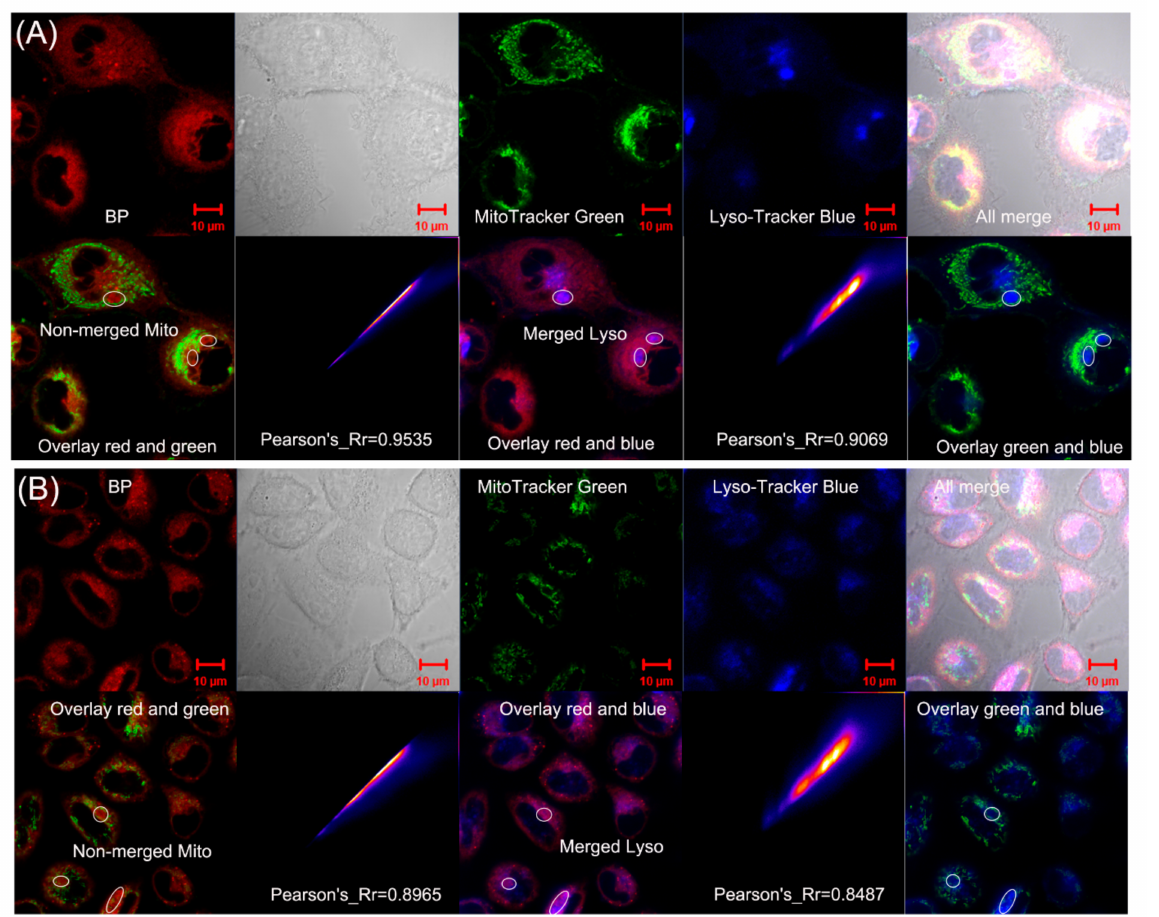
Figure 6. Colocalization experiments of BP with MitoTracker Green FM and LysoTracker Blue DND- 22 in U87 cells ( A ) and HeLa cells ( B ). Blue channel: λ ex = 405 nm, λ em = 405–450; Green channel: λ ex = 488 nm, λ em = 490–530 nm; Red channel: λ ex = 561 nm, λ em = 600–750